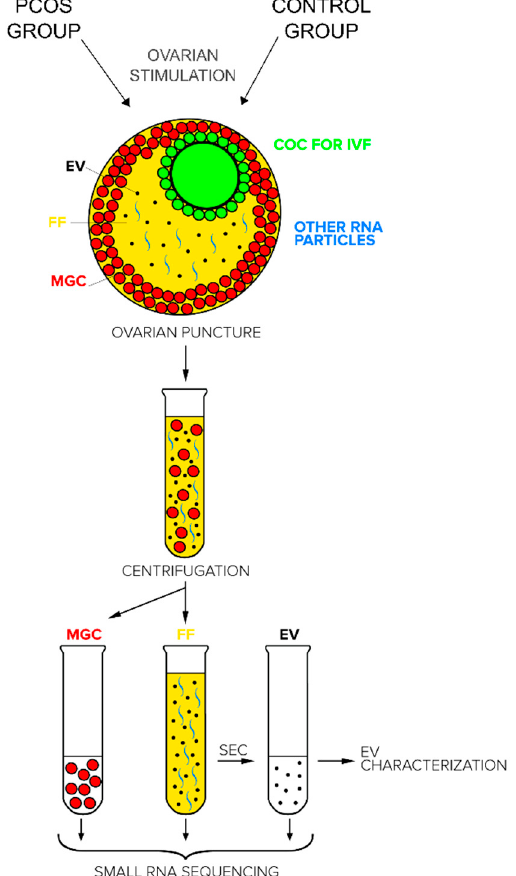
Figure 1. Schematic description of sample collection and processing from human pre-ovulatory follicles of polycystic ovary syndrome (PCOS) patients and fertile control group. COC—cumulus oocyte complex (green), FF—cell-free follicular fluid (yellow) containing extracellular vesicles (EV, black) and non-EV-bound RNA (blue), IVF—in vitro fertilization, MGC—mural granulosa cells (red). EVs were characterized for their size, concentration, and surface markers. All three sample types underwent small RNA sequencing, and the results were validated by real-time quantitative PCR (RT-qPCR). The main characteristics of patients and the number of analyzed samples according to each method are presented in Table 1. Table 1. General characteristics of study participants by used method.